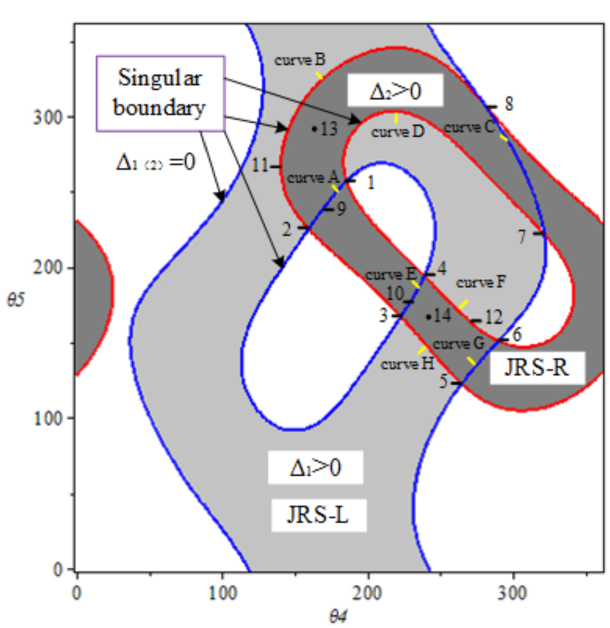
Table 1. Symbols and explanations. Symbol Explanation Valuation Z i joint rotation Z i is a rotation of the joint which depends on the exterior angle θ i side rotation S ij is the arc of the great circle of the sphere which depends on exterior angles variables spherical central angles